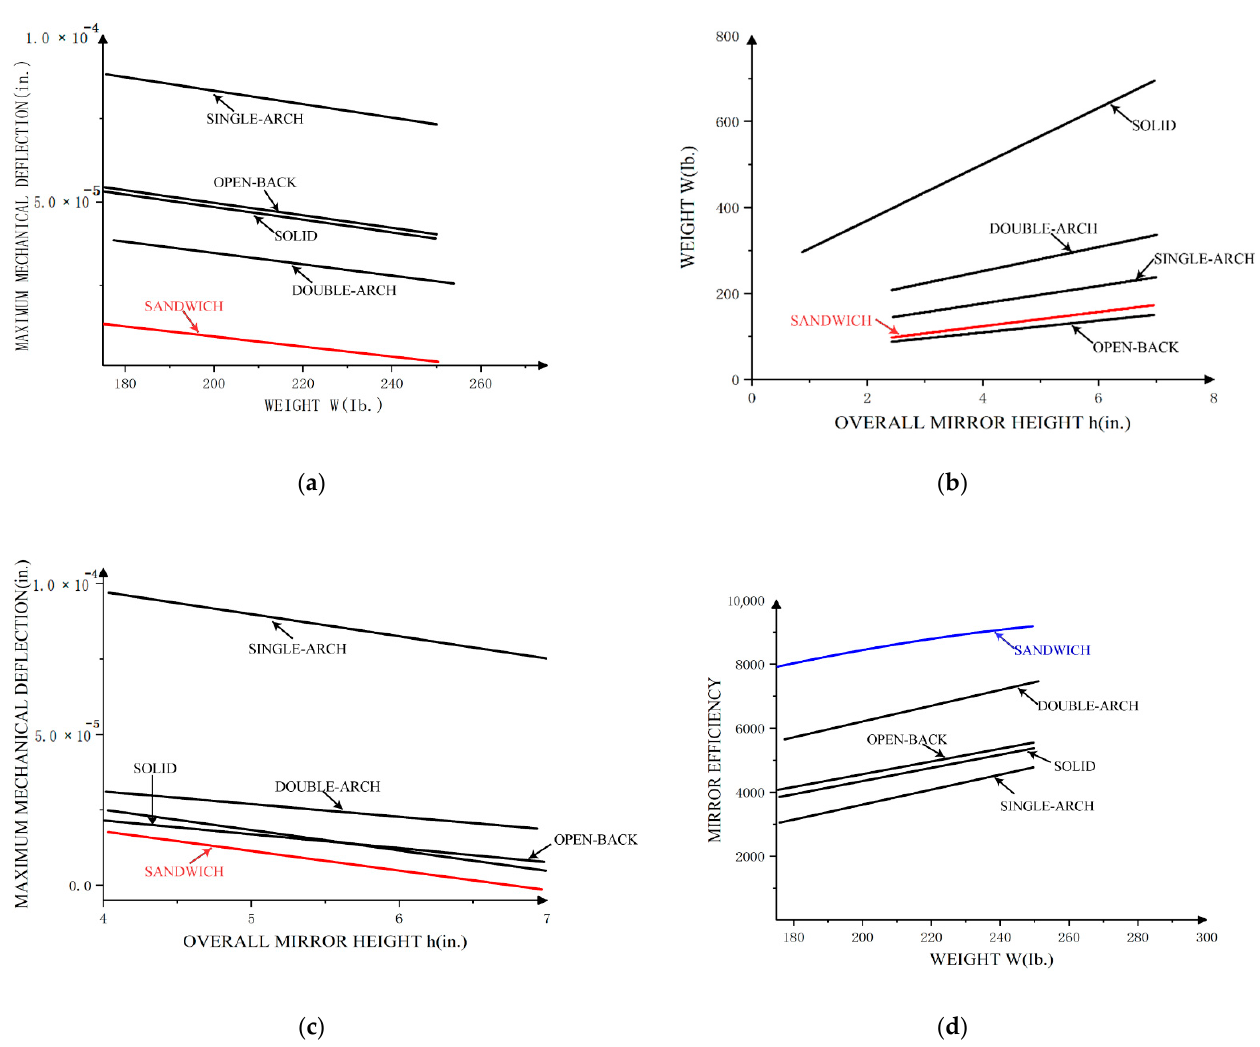
Figure 3. ( a – d ) A series of performance comparison images of 5 lightweight structures. It can be seen that the sandwich mirror has the best mirror efficiency of the [19].